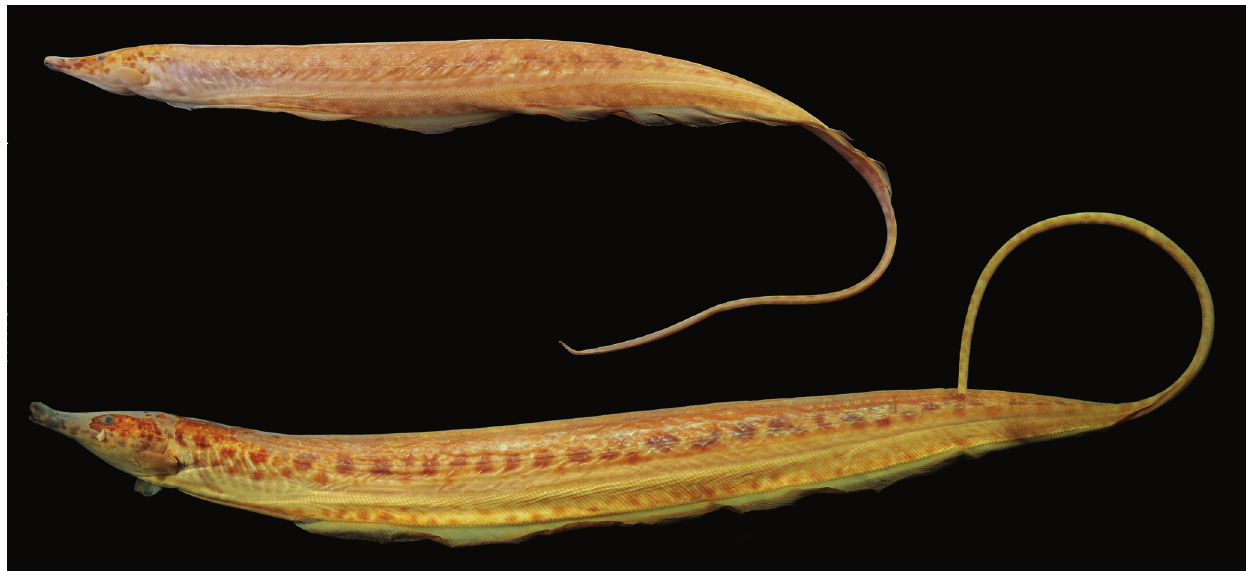
Fig. 1. Iracema caiana , MZUSP 49205 (paratypes). Specimens used for the CT-scan images: above 235 mm SL, below 345 mm